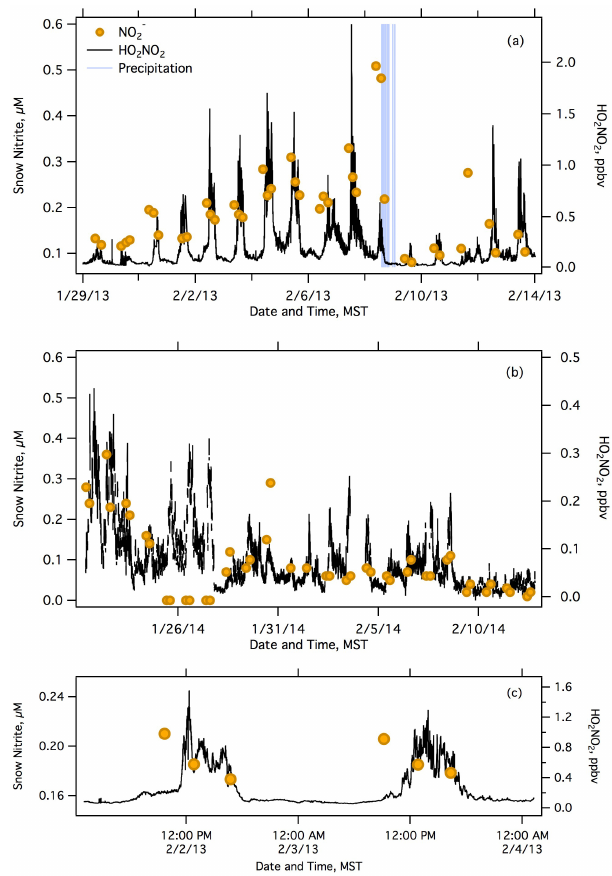
Figure 7. Displayed are gas phase HO 2 NO 2 observations made dur- ing two wintertime ozone events in the Uintah Basin, UT, observed in 2013 (a) , and through the entire 2014 study (b) . Measurements of the nitrite content of the snow surface taken during the same time periods are also shown. In 2013, a precipitation event that occurred on the afternoon of 8 February, shown as the period in blue, added fresh surface snow and flushed pollutants out of the basin result- ing in lower ambient PNA and snow nitrite levels. Panel (c) shows in more detail periods from the 2013 measurements to better illus- trate the daily reduction in snow surface nitrate that was regularly